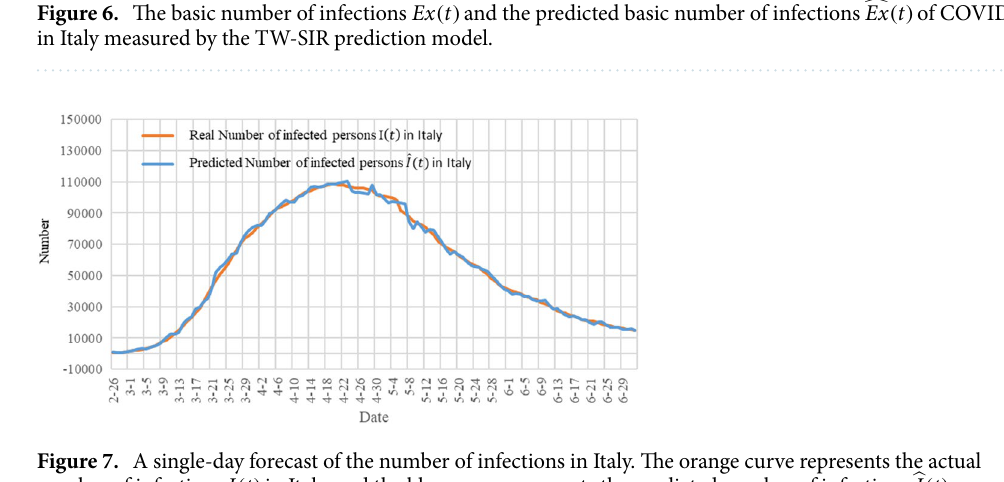
Figure 7. A single-day forecast of the number of infections in Italy. The orange curve represents the actual number of infections I ( t ) in Italy, and the blue curve represents the predicted number of infections